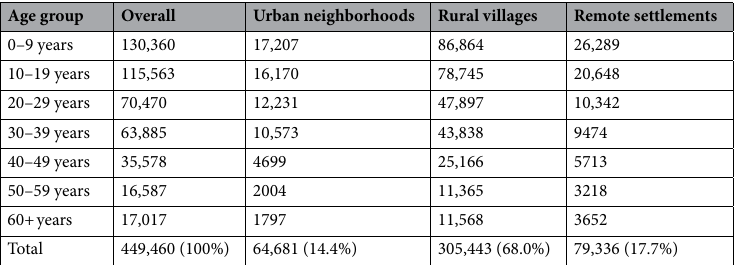
Age group Overall Urban neighborhoods Rural